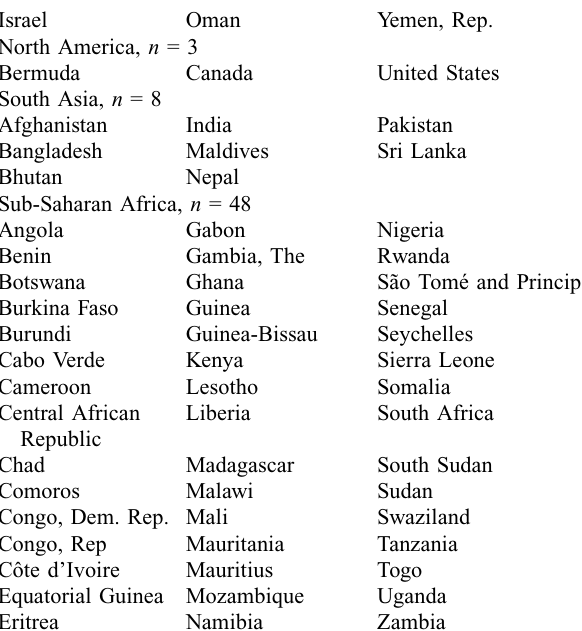
Table 2. Countries by World Bank Regions, adapted